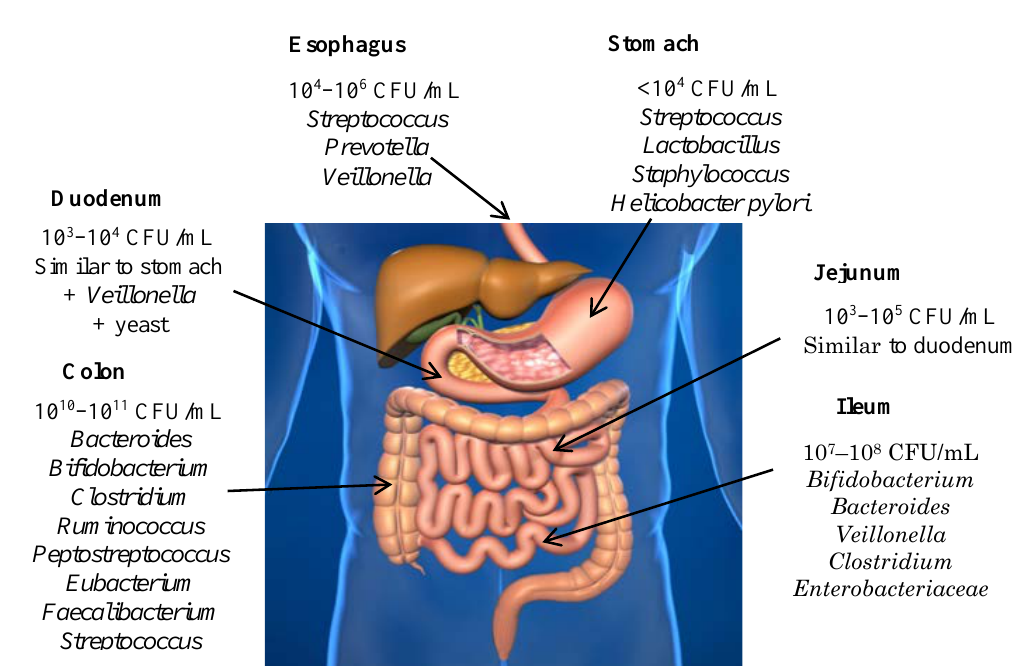
Figure 2. Distribution and composition of bacterial species in the gastrointestinal tract. CFU: colony forming